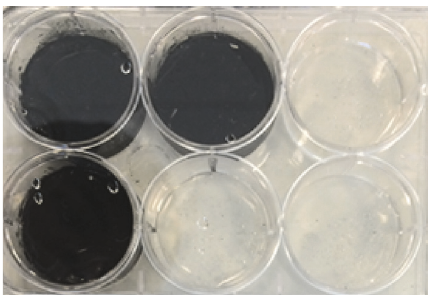
Figure 2: Plates containing surface-crosslinked collagen on films with no CNTs (clear) and high CNTs